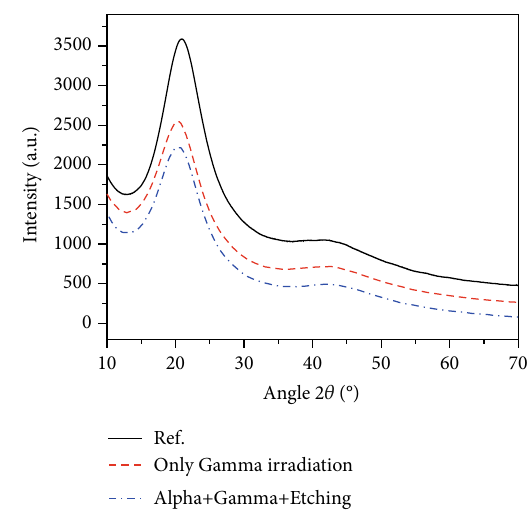
Figure 1: XRD spectra of reference, gamma irradiated, and irradiated plus chemically etched PM-355 2 θ = 21 : 29 ° is noticed for the reference sample. This indicates